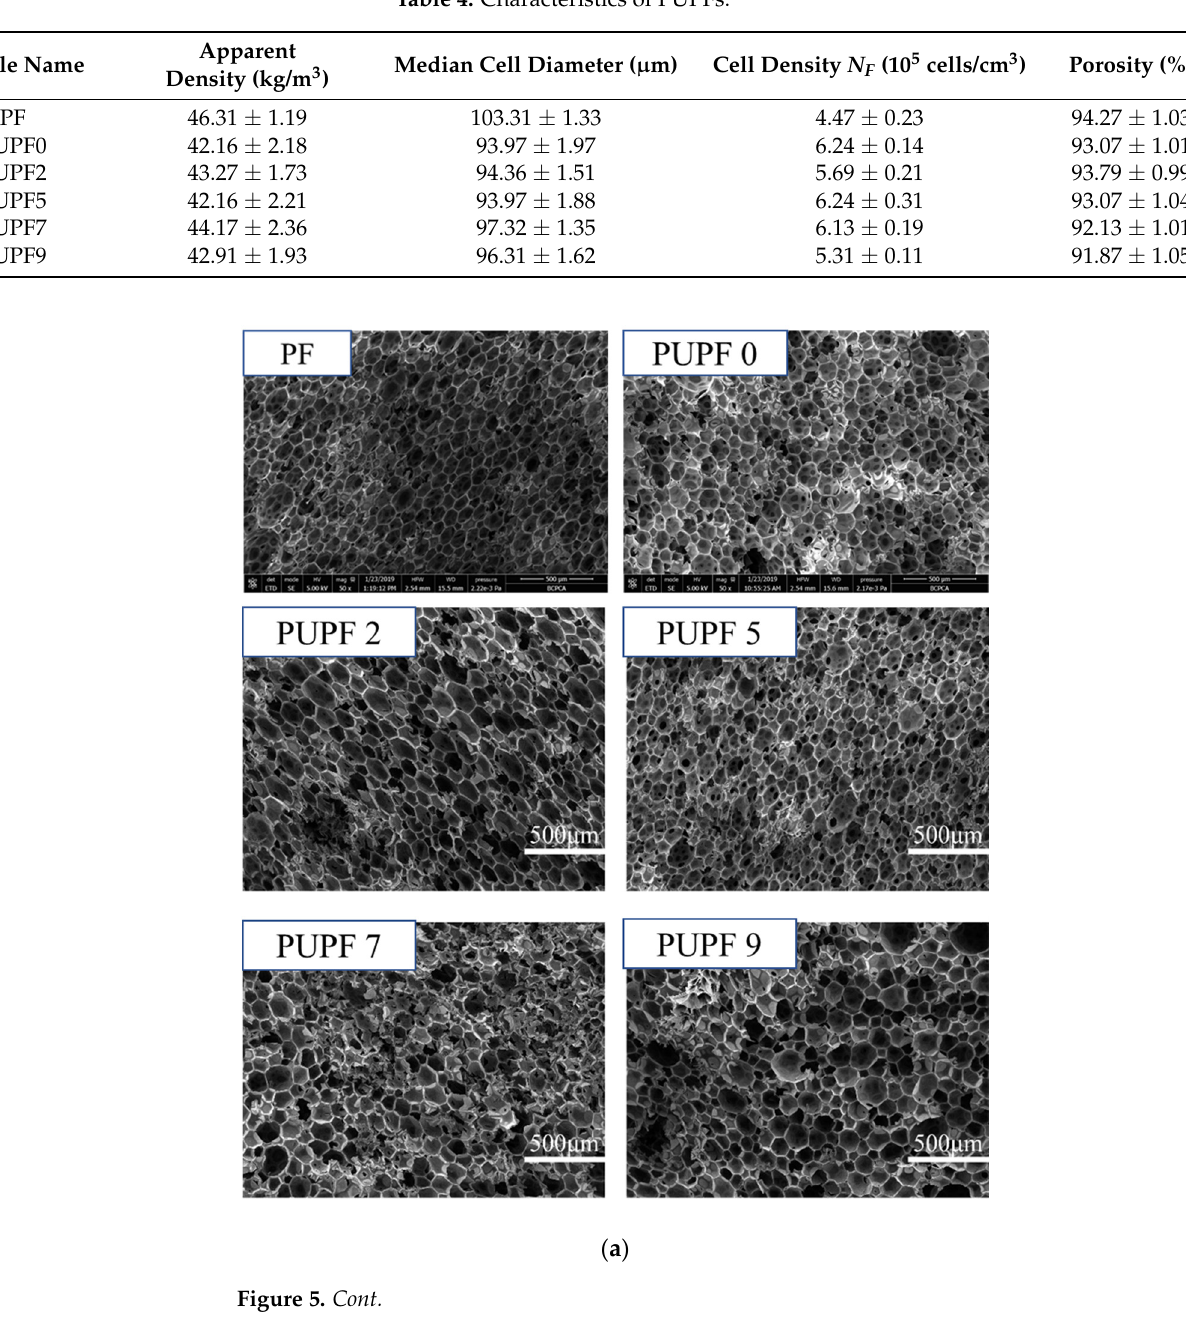
Table 4. Characteristics of PUPFs.